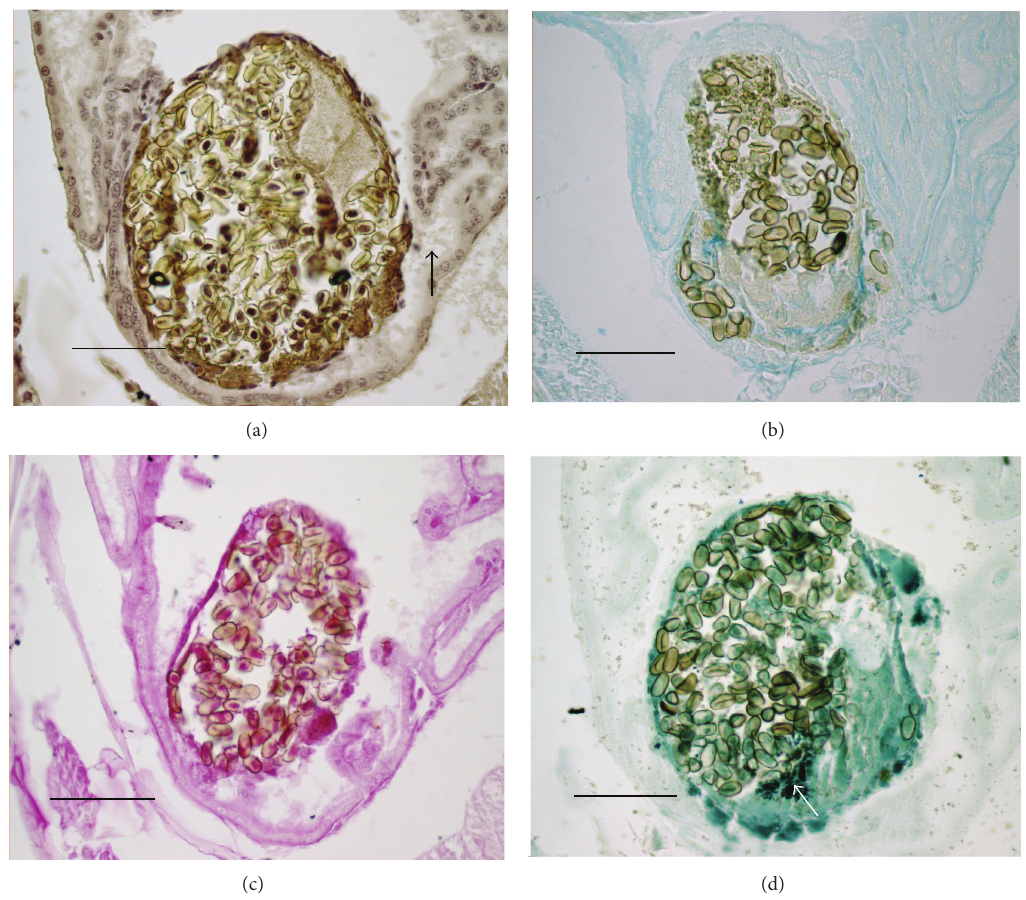
Figure 3: Histochemical staining of necrotic A. renale within the host. (a) Harris hematoxylin staining reveals an unrecognizable mass of material with ova. Hostantennal gland tubulelumina contain lightly stained material (arrow).(b) Alcian bluepH. 2.5 staining reveals a change in the staining pattern compared to healthy trematodes, with no distinct integument. Staining of the host tissue reveals the same results as shown with healthy parasites. (c) Periodic acid-Schiff staining for neutral sugars reveals strongly stained areas of material on the necrotic mass surface along with ova. (d) Ferro-ferricyanide staining for tyrosine-based structures reveals an intensely stained vitellarium (arrow) and lighter staining in other areas of the mass likely due to the breakdown of the vitellarium. (a)–(d) Bars = 100 𝜇